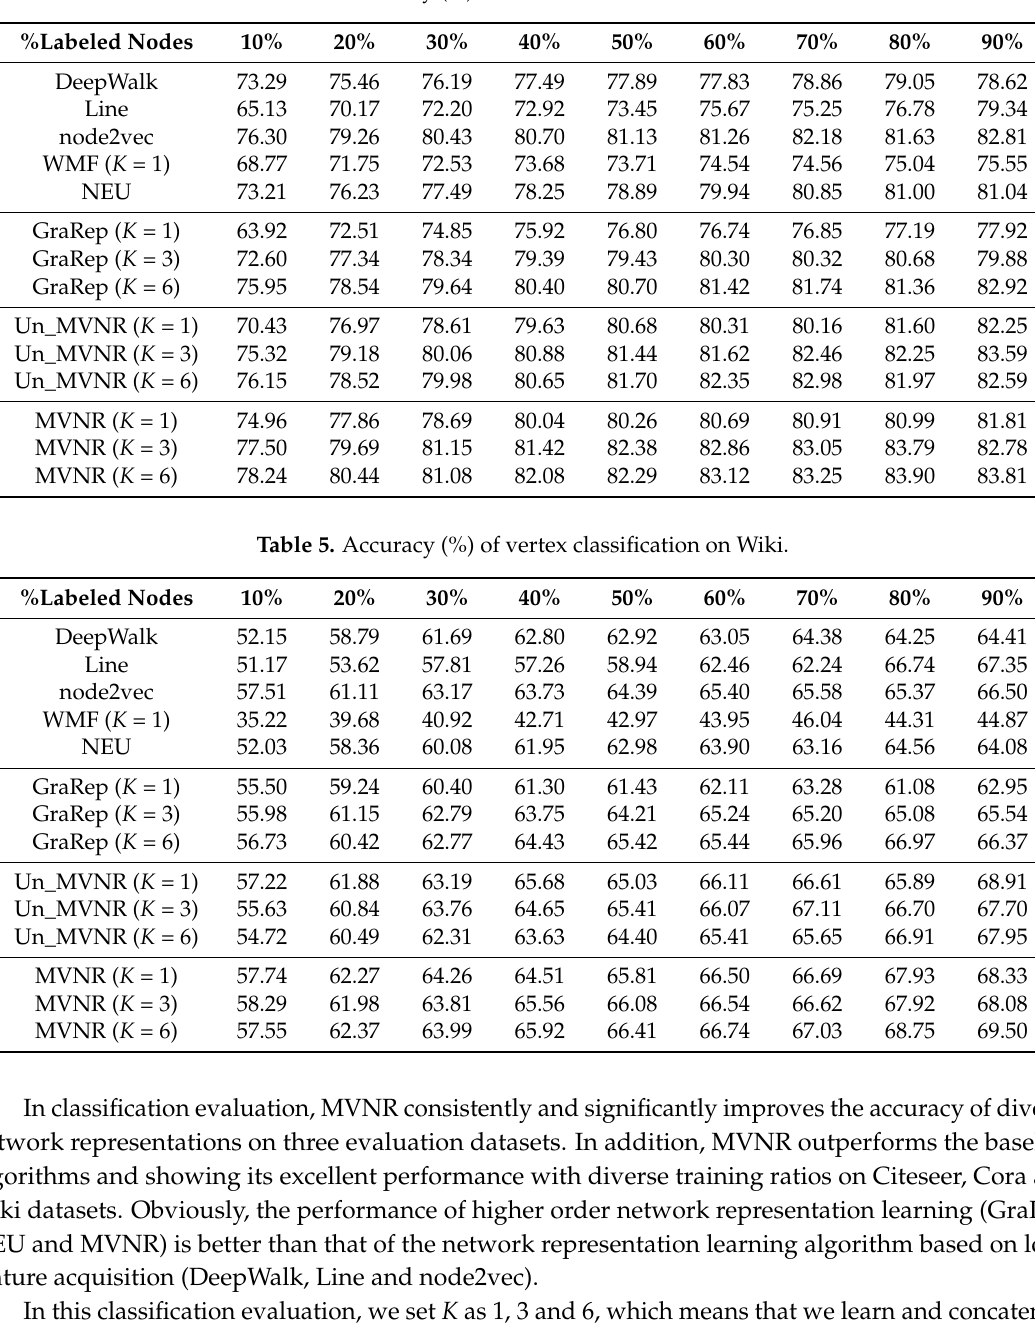
Table 4. Accuracy (%) of vertex classification on Cora.